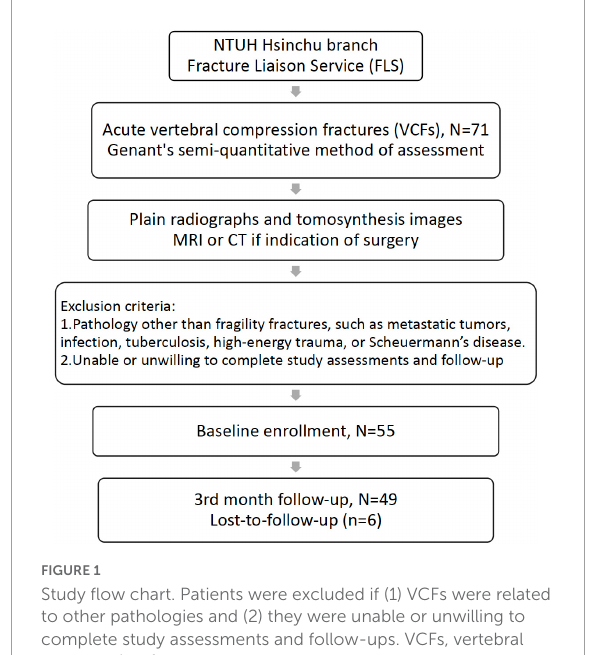
FIGURE1 Study flow chart. Patients were excluded if (1) VCFs were related to other pathologies and (2) they were unable or unwilling to complete study assessments and follow-ups. VCFs, vertebral compression